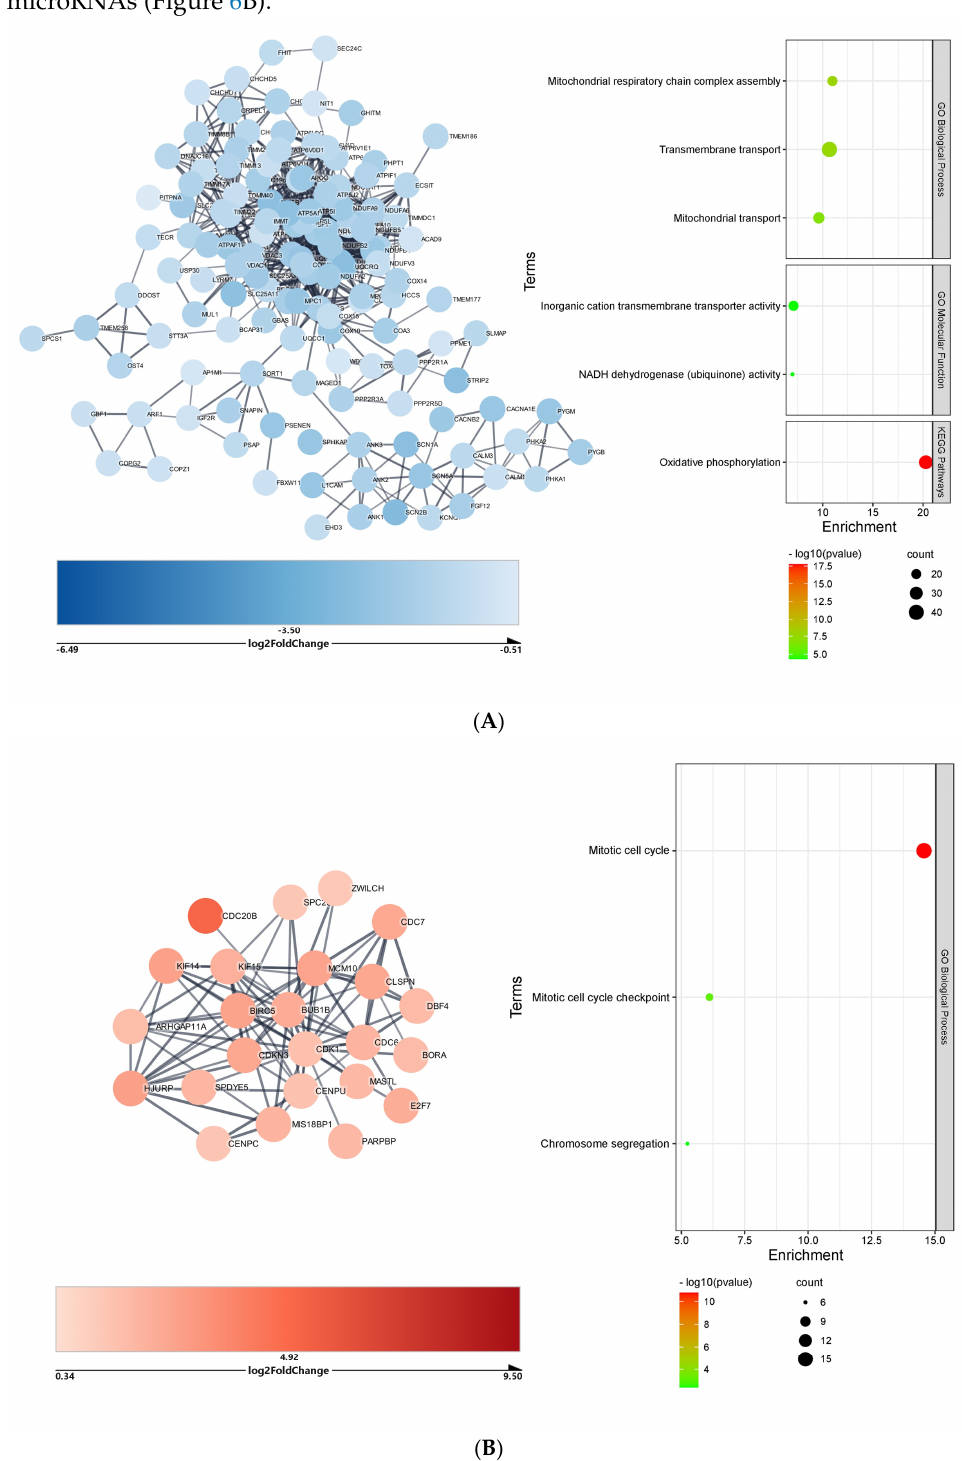
Figure 2. Cluster and functional enrichment analysis of COVID − 19 heart DEGs targeted by differentially expressed microRNAs: STRING interaction confidence score >0.7; Markov clustering inflation value = 4; STRING Enrichment FDR < 0.05; redundancy score = 0.5. ( A ) Cluster and functional enrichment analysis of COVID-19 heart downregulated DEGs targeted by upregulated microRNAs. ( B ) Cluster and functional enrichment analysis of COVID-19 heart upregulated DEGs targeted by downregulated